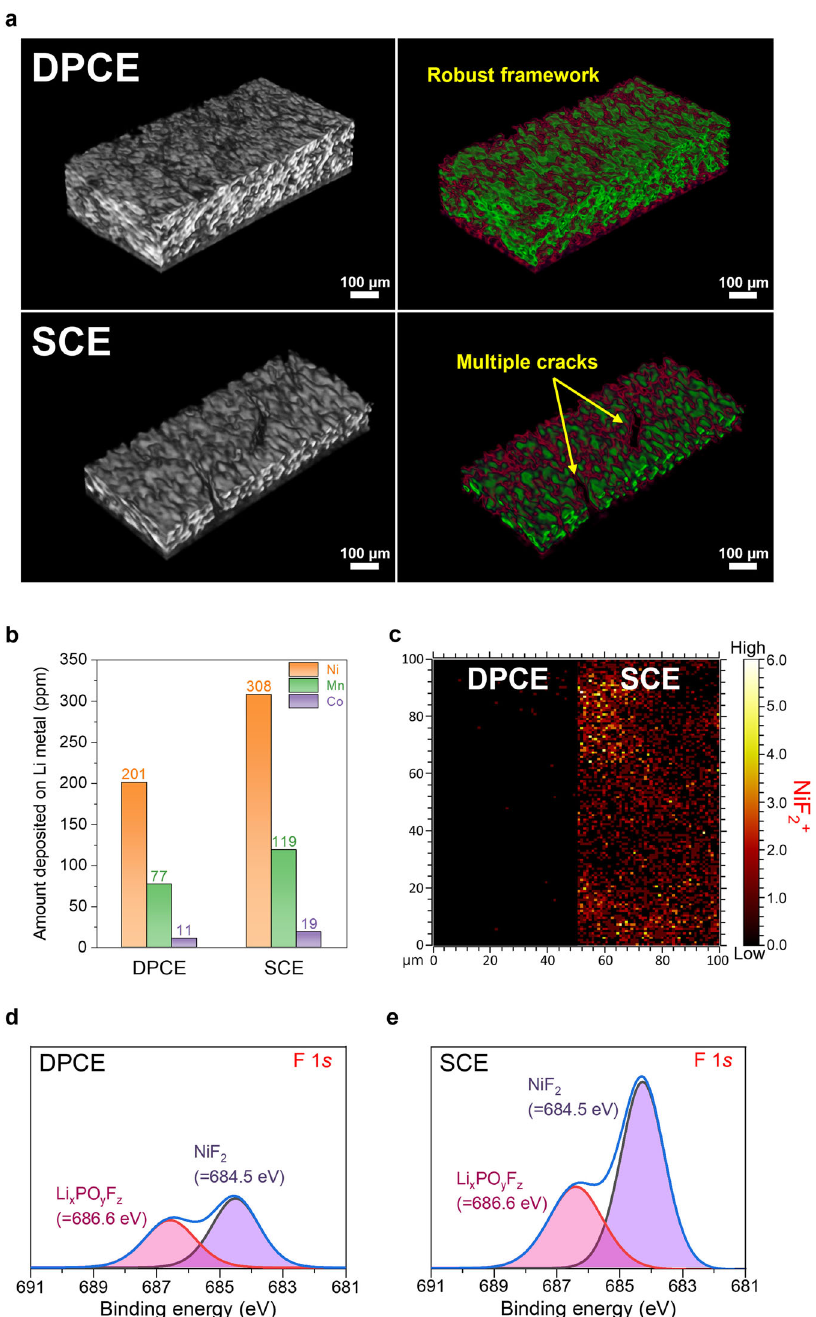
Fig. 4 | Morphologies and postmortem analysis of the cycled DPCE (versus SCE).a Micro-CTimagesoftheDPCEandSCE.Theactivematerial(NCM712)phase is labeled green, and the carbonphase islabeledred. b Amount of metallicNi, Mn,